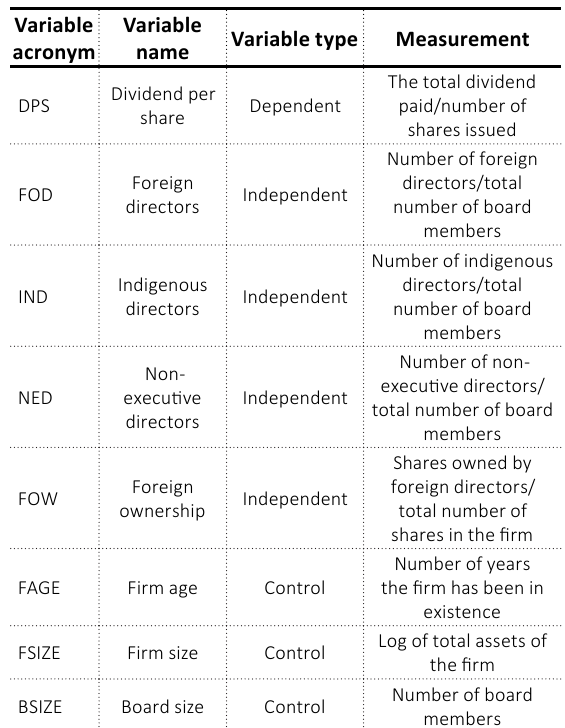
Table 1. Summary of